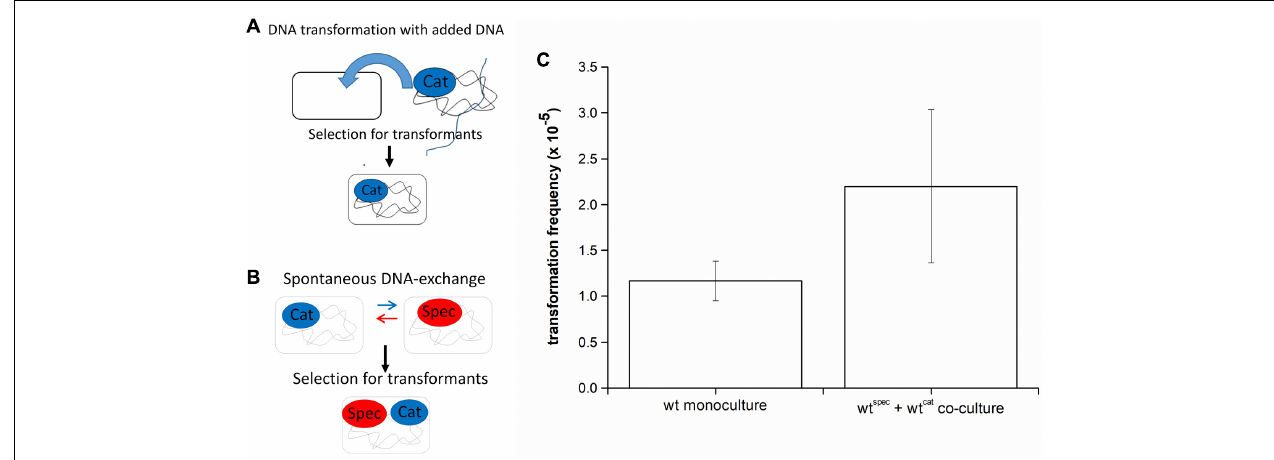
FIGURE 1 | (A) A schematic representation of the transformation assay with added DNA. Bacillus subtilis strain was grown in monoculture in CM medium for 6 h at 37 ◦ C and 200 rpm and then genomic DNA carrying an antibiotic resistance marker (chloramphenicol-Cat R ) was added to the medium. This enabled cells to receive DNA and provided an opportunity to develop resistance to antibiotic (Cat-Cat R ). (B) A schematic representation of the DNA exchange assay. Two B. subtilis strains, each carrying a different antibiotic resistance marker (chloramphenicol-Cat R or spectinomycin-Spec R ) were grown in co-culture in CM medium for 8 h at 37 ◦ C and 200 rpm. This enabled spontaneous DNA exchange between the two strains and provided an opportunity to develop resistance to both antibiotics (Cat and Spec-Cat R Spec R ). (C) Transformation frequency of Bacillus subtilis PS-216 wild-type strain in monoculture and in co-culture grown in CM medium. The values presented are means and standard errors ( n =